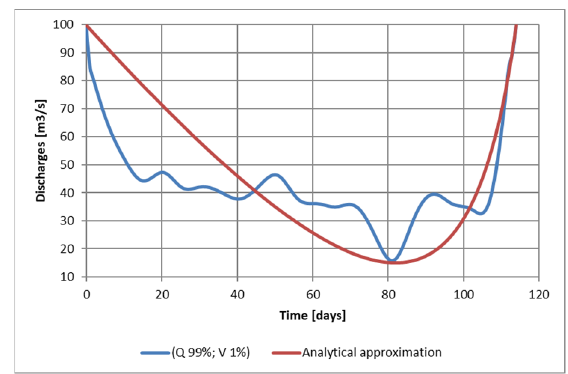
Figure 13. Synthetic drought hydrograph and its analytical